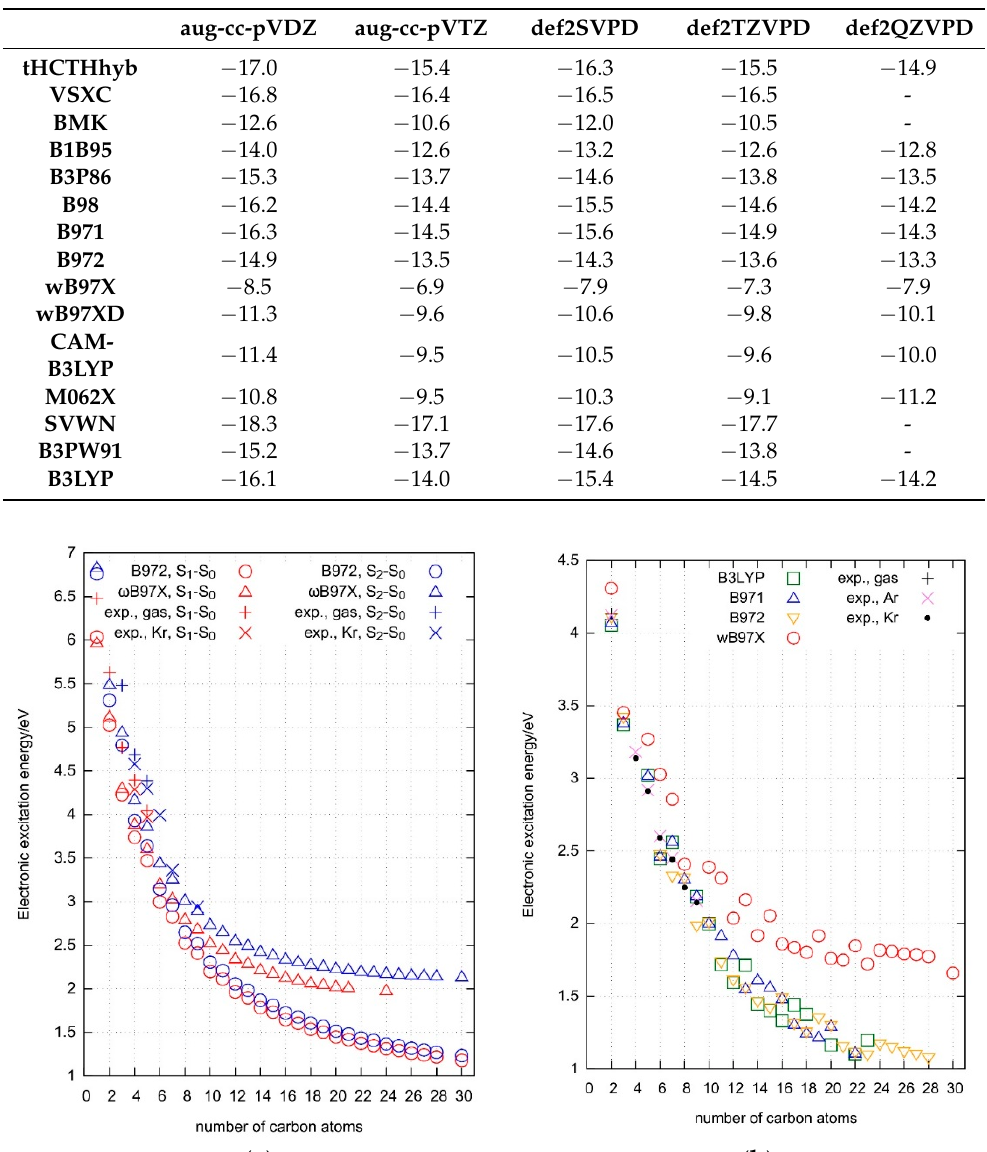
Table 2. Mean percent errors (with respect to the measured Kr-matrix values) of the singlet-singlet excitation energy calculations performed with various functional/basis set combinations. See Table S2 for ∆ st , and ∆ abs (defined by Equations (3) and (4)).